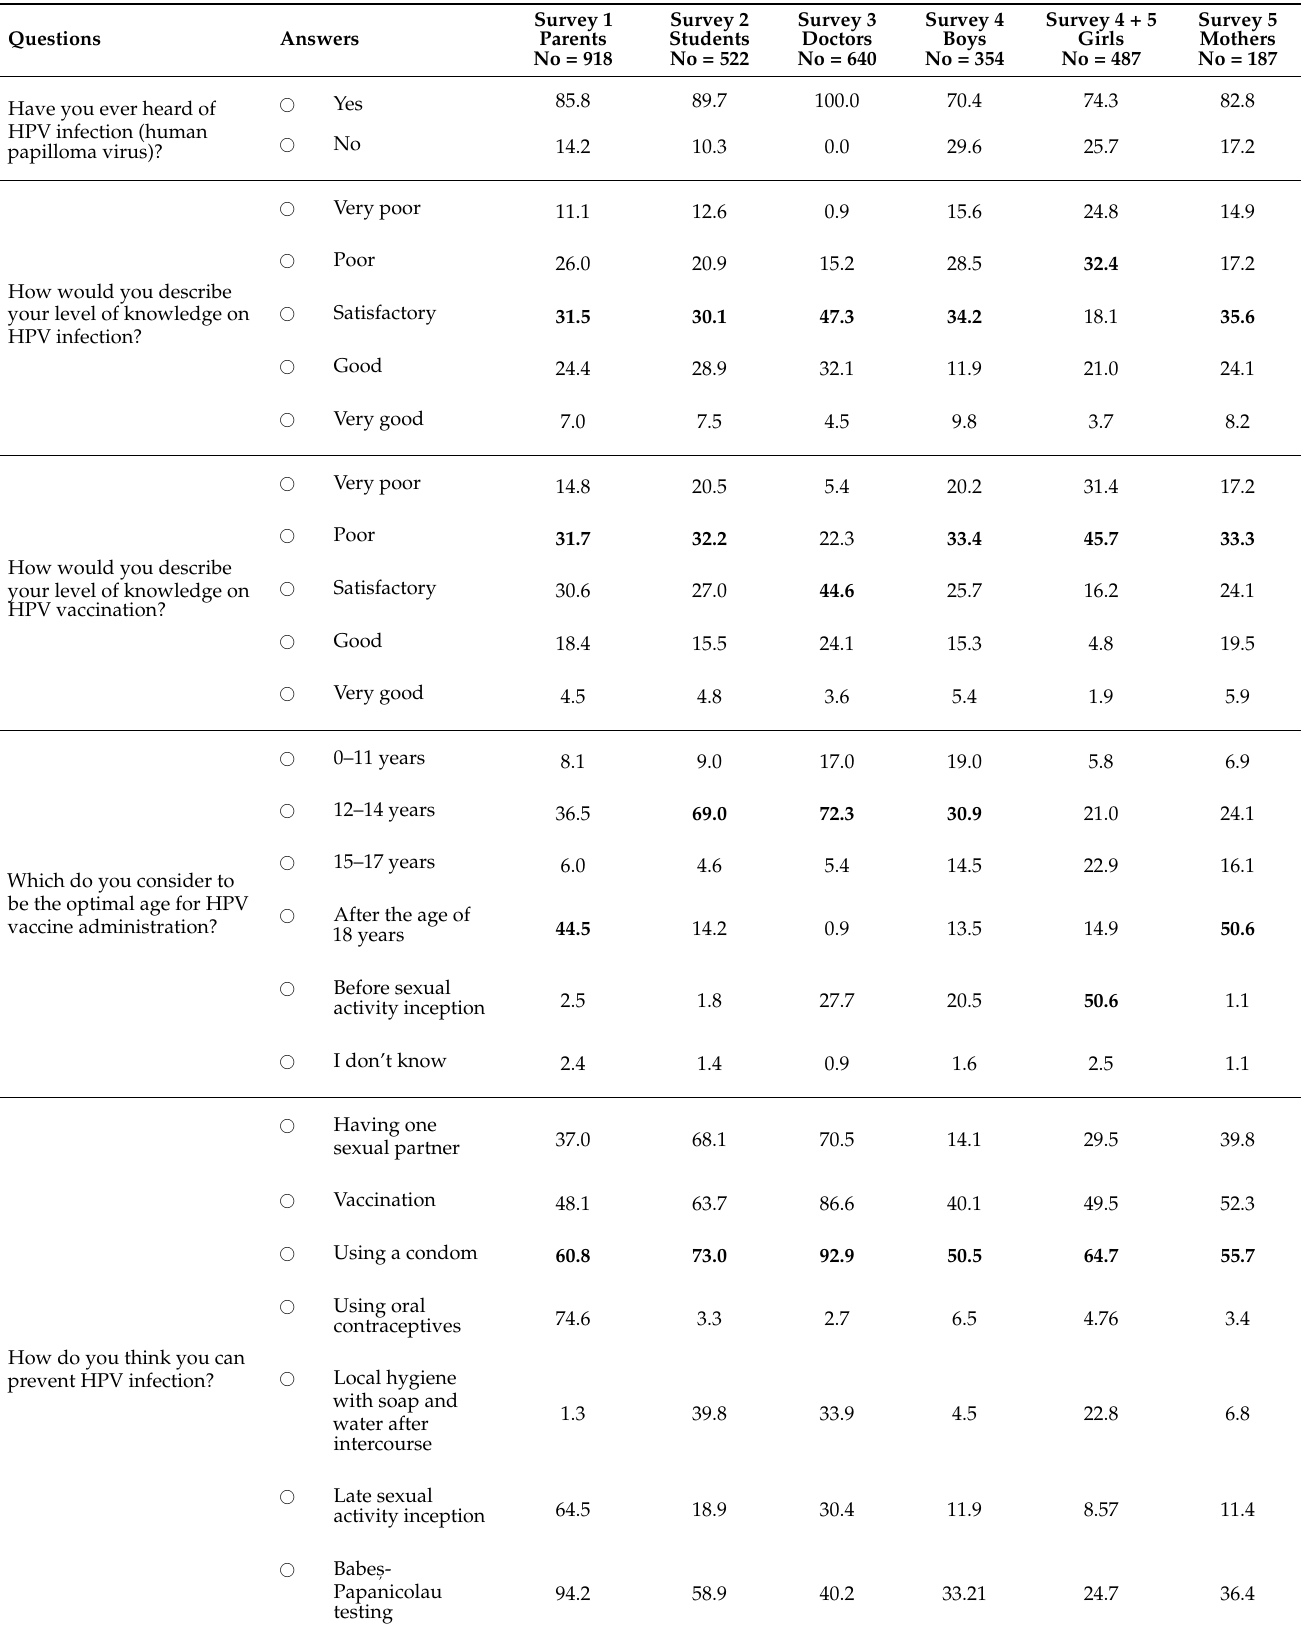
Table 1. Level of knowledge on HPV infection and